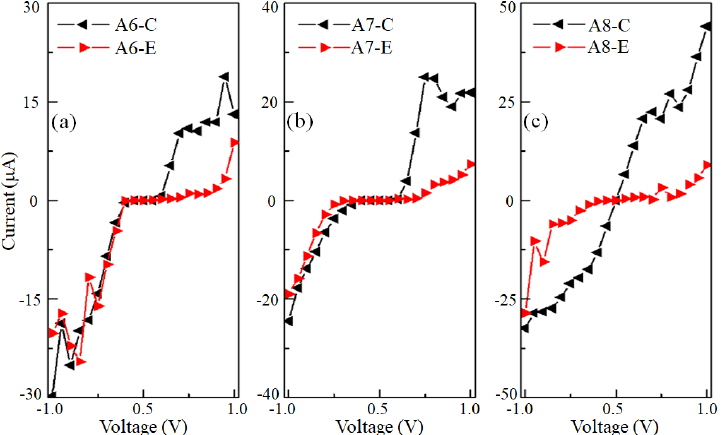
Figure 3. The I − V characteristics for AA − P 2 ∠ ASiNR devices with widths of 6, 7, and 8 (N = 6, 7, and 8) in ( a − c ),